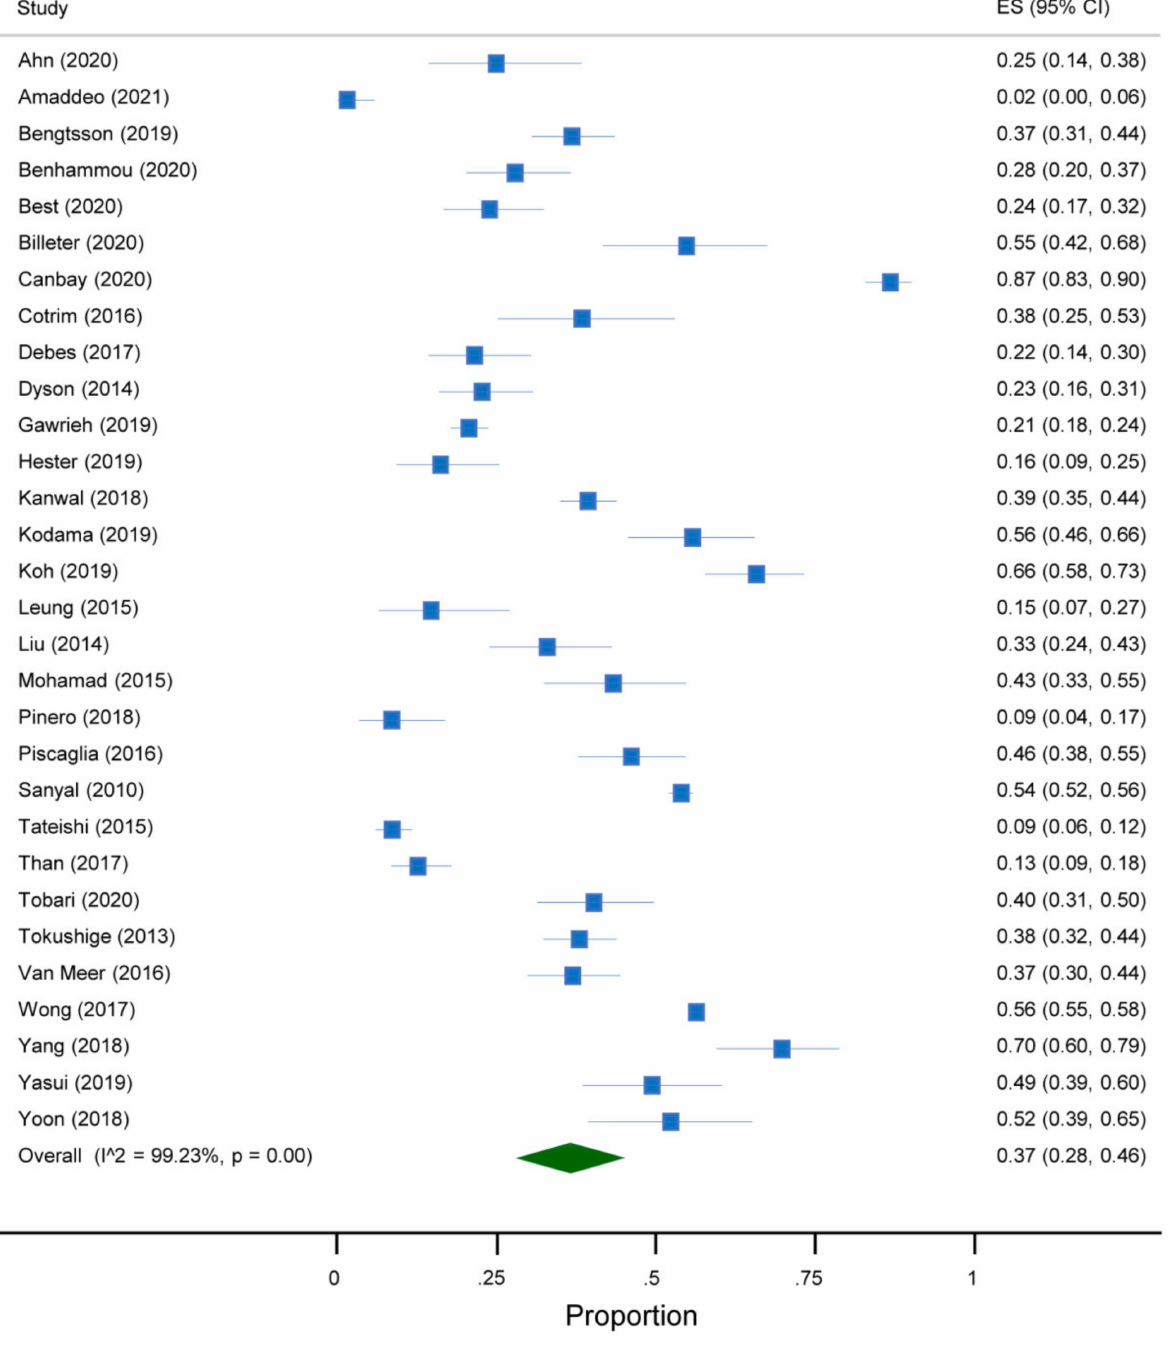
Figure 2. Forest plot of the absence of cirrhosis in subjects with NAFLD-associated